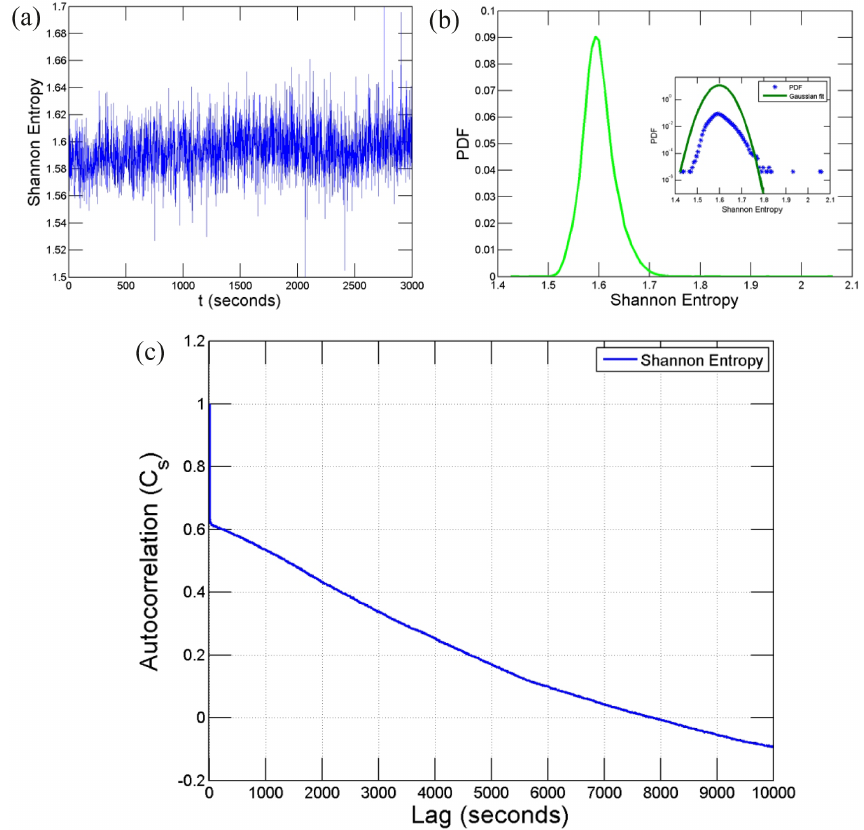
Figure 5. The first 3000 samples of the time series of Shannon entropy in (a) , PDF of Shannon entropy along with a Gaussian fit in semi-log plot (inset) in (b) and the autocorrelation of Shannon entropy in (c)